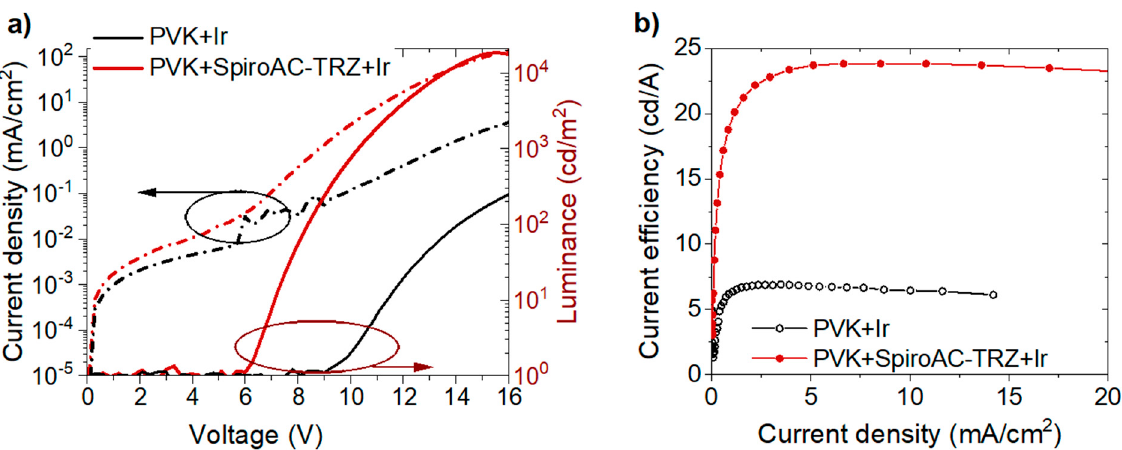
Figure 7. Working parameters of OLEDs with emissive layers: PVK + 2 wt% Ir and PVK + 25 wt% SpiroAC–TRZ + 2 wt% Ir . Device structure: ITO/PEDOT:PSS (20 nm)/LEL (65 nm)/Bphen (40 nm)/ Liq (2 nm)/Ag (100 nm). ( a ) Current density–voltage–luminance ( J – V – L ) characteristics; Current density–voltage characteristics (left) and luminance–voltage characteristics (right); ( b ) Current efficiency vs current density.